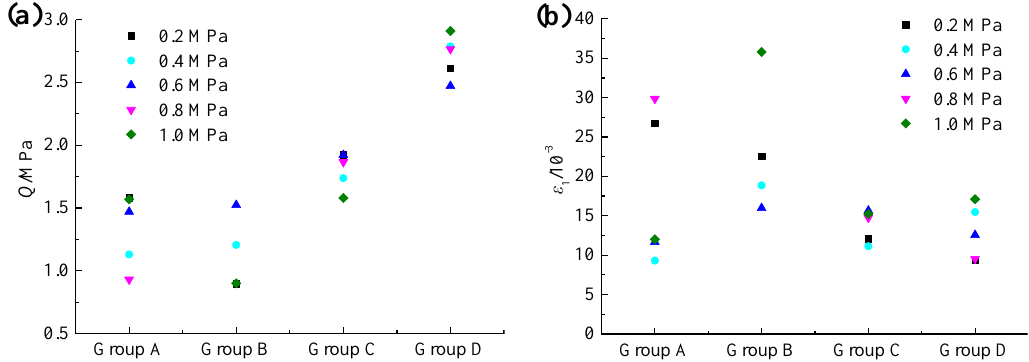
Figure 11. ( a ) The relationship between material strengths and different particle sizes; ( b ) the Figure11. ( a )Therelationshipbetweenmaterialstrengthsanddi ff erentparticlesizes; ( b )therelationship relationship of ε 1 and different particle sizes. of ε 1 and di ff erent particle